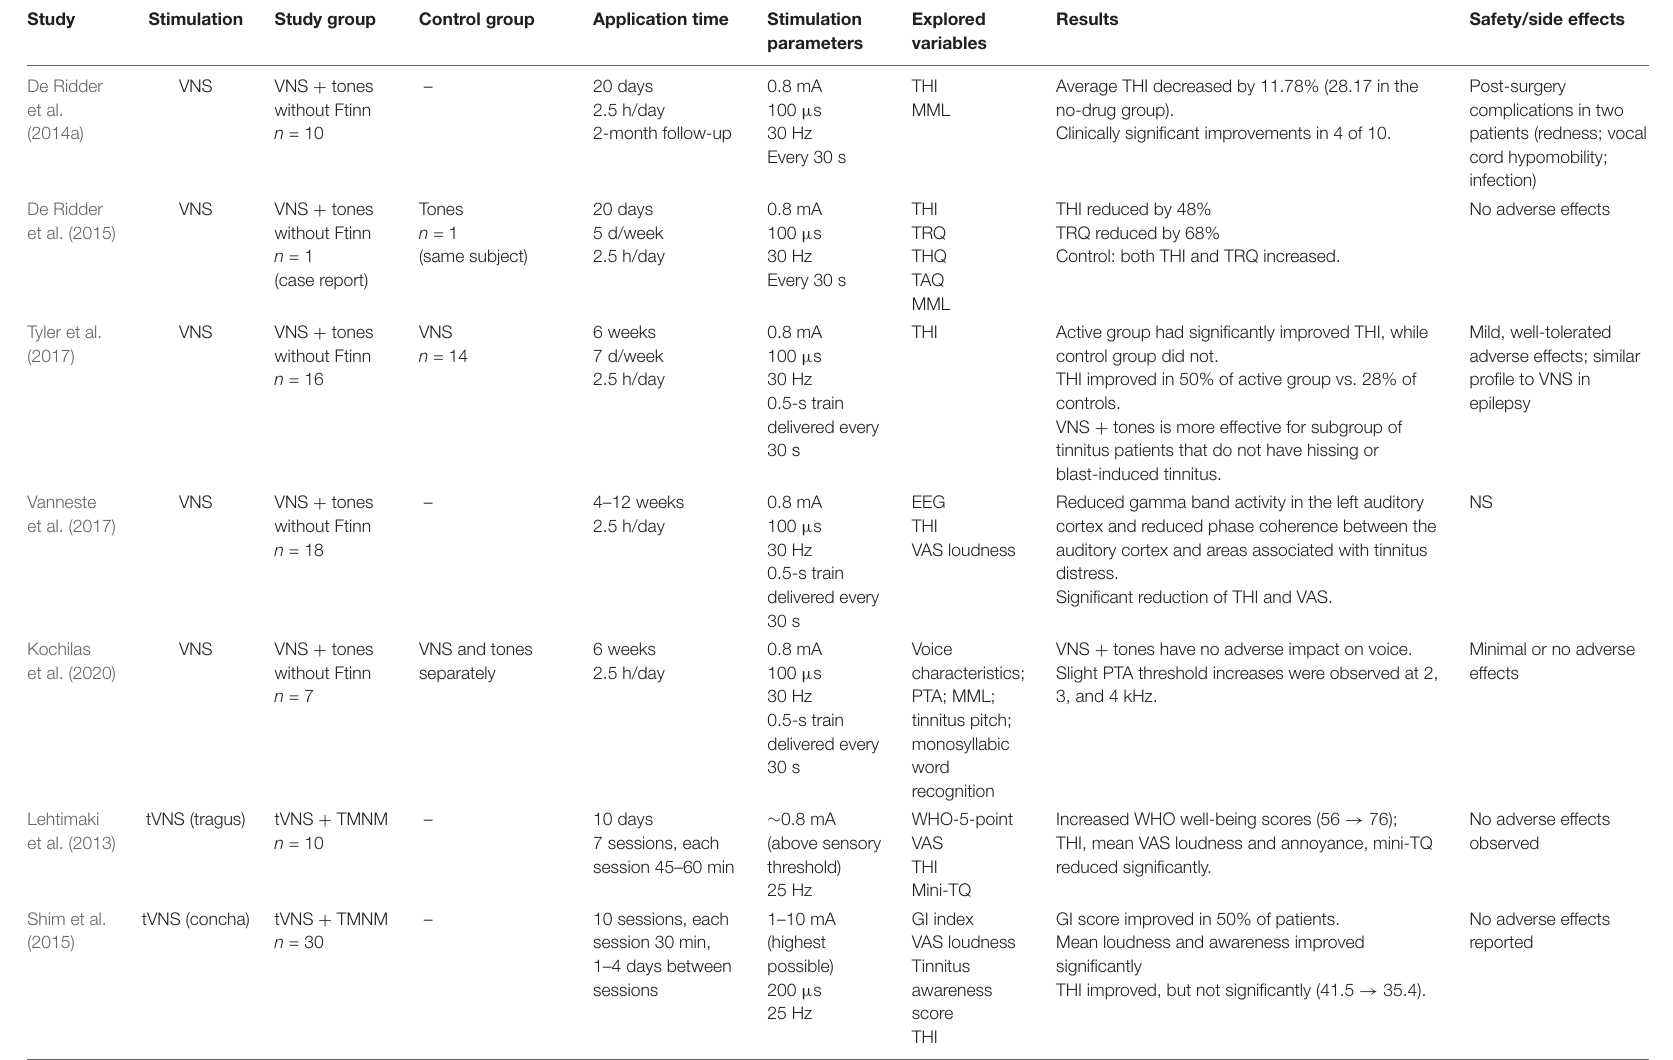
TABLE 3 | Summary of the existing studies on (t)VNS paired with sound stimuli in patients with tinnitus.